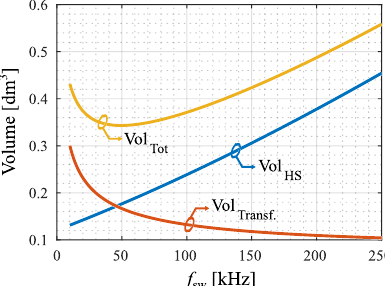
Figure 4. Volume of the power transformer and heatsink in DAB versus the switching frequency.